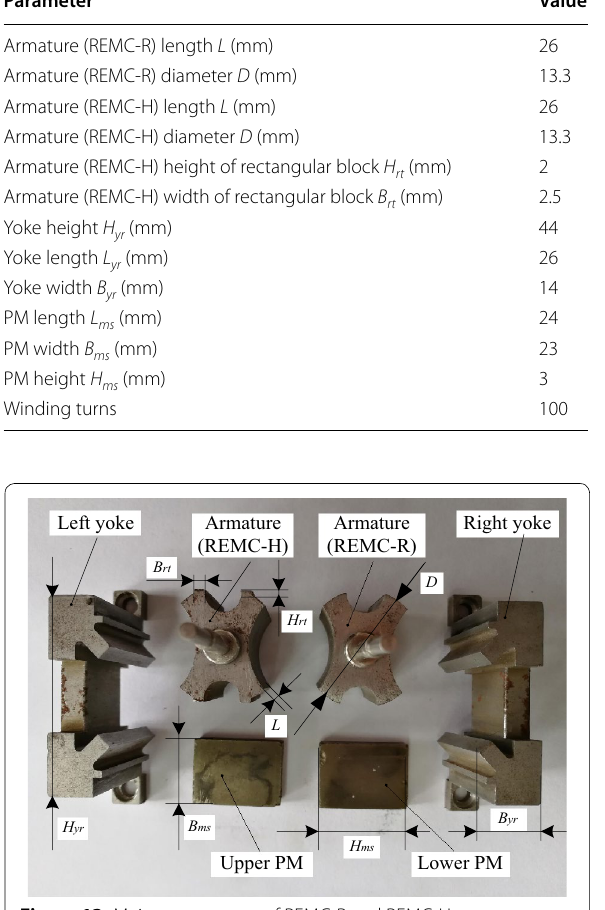
Figure 13 Main components of REMC-R and REMC-H